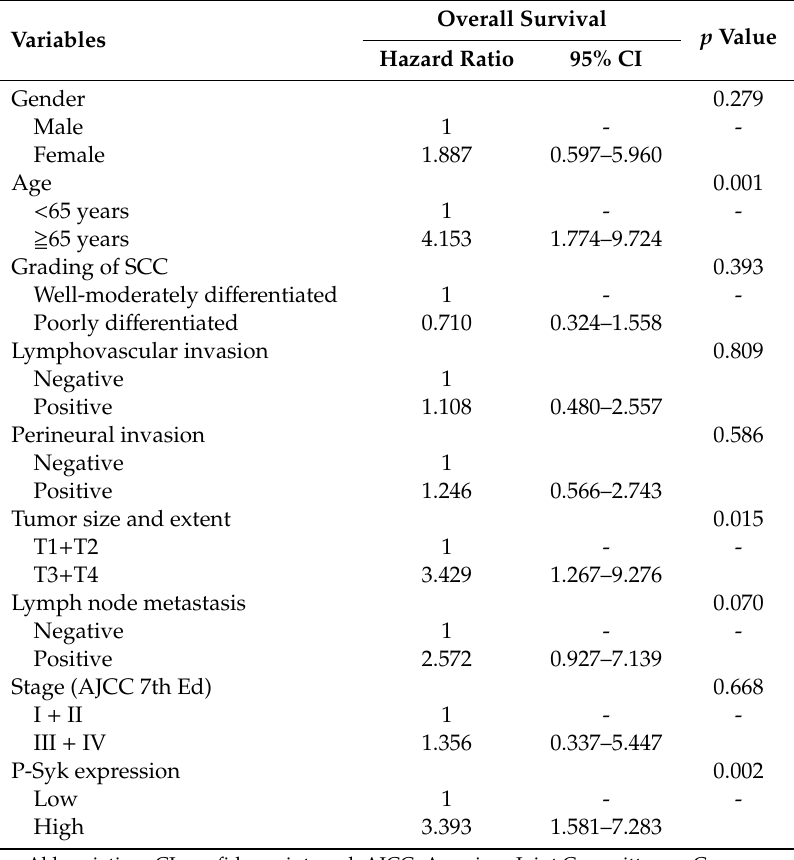
Multivariate analysis of clinicopathological factors and p-Syk expression a ff ecting overall